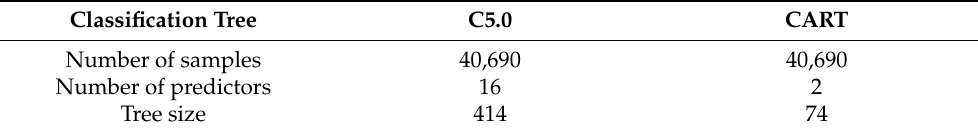
Table 5. C5.0 model fitting